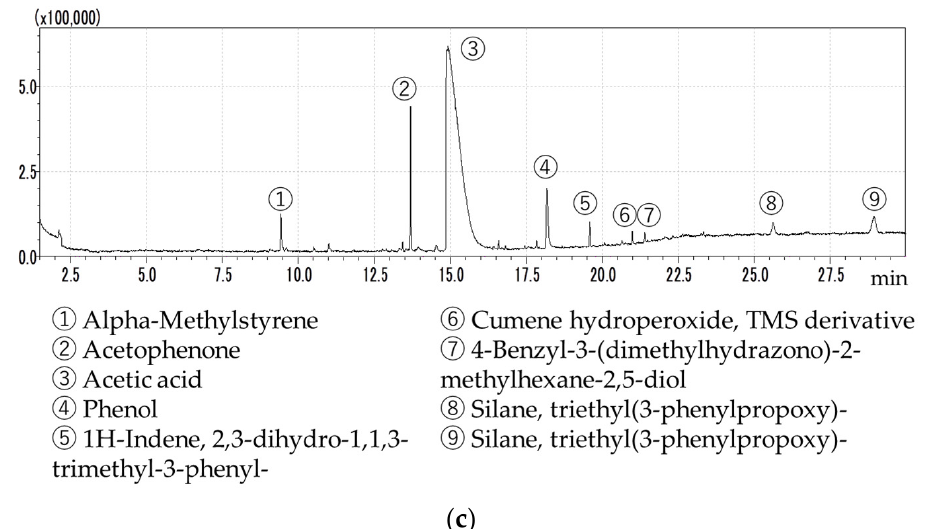
Figure 4. Results of composition analysis by GC-MS of three types of cable samples. ( a ) LV cable; ( b ) MV cable A; ( c ) MV cable B.